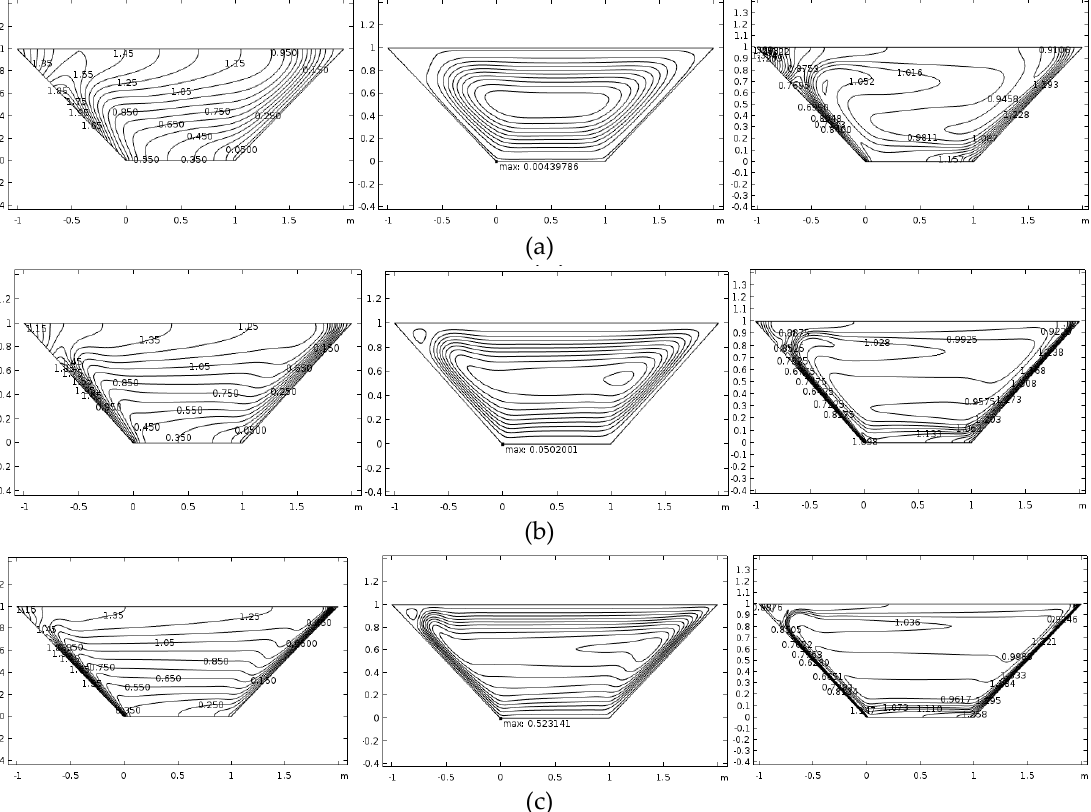
Figure 2. Isotherms, streamlines, and isoconcentrations for Pr = 7, ϕ = π / 4, κ = 1, ε = 0.5, and ( a ) Ra = 10 4 , ( b ) Ra = 10 5 , ( c ) Ra = 10 6 .